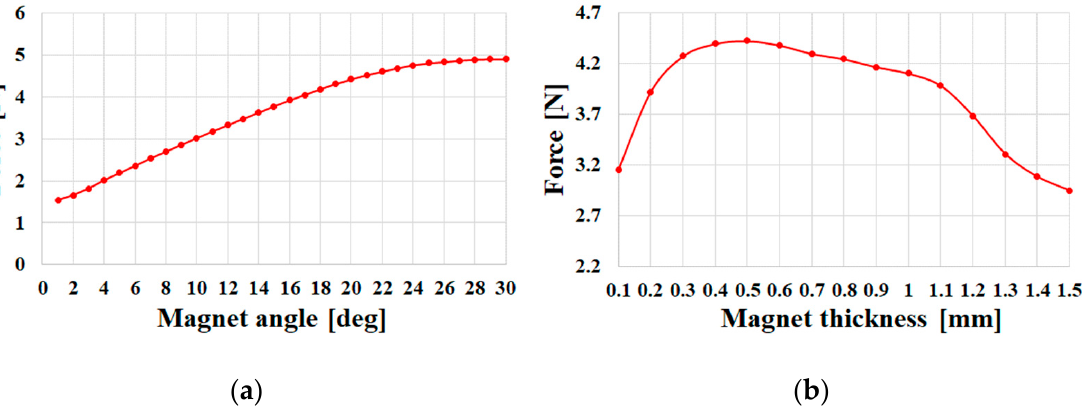
Figure 11. Force analysis depending on variables of the magnet: ( a ) magnet angle and ( b ) magnet thickness.